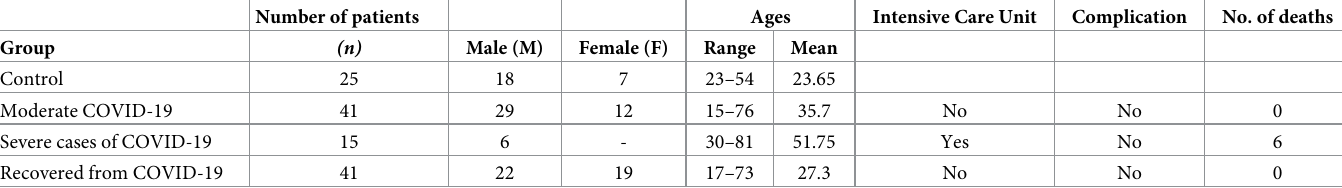
Table 1. Patient disposition in the study groups (n = 122).